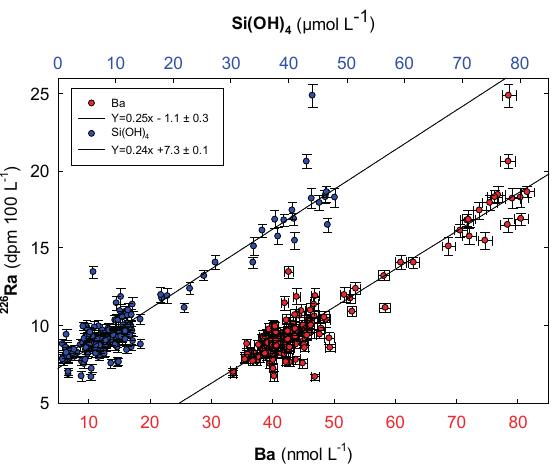
Figure 5. Relationships between 226 Ra and Ba (red dots) and be- tween 226 Ra and Si(OH) 4 (blue dots) along the GA01 section in the North Atlantic. The best linear fit for the two plots is also reported ( R = 0 . 93 for the two plots). The slopes of the relationships be- tween 226 Ra and Ba and between 226 Ra and Si(OH) 4 are expressed in 10 − 2 dpmnmol − 1 and in 10 − 2 dpmµmol − 1 ,